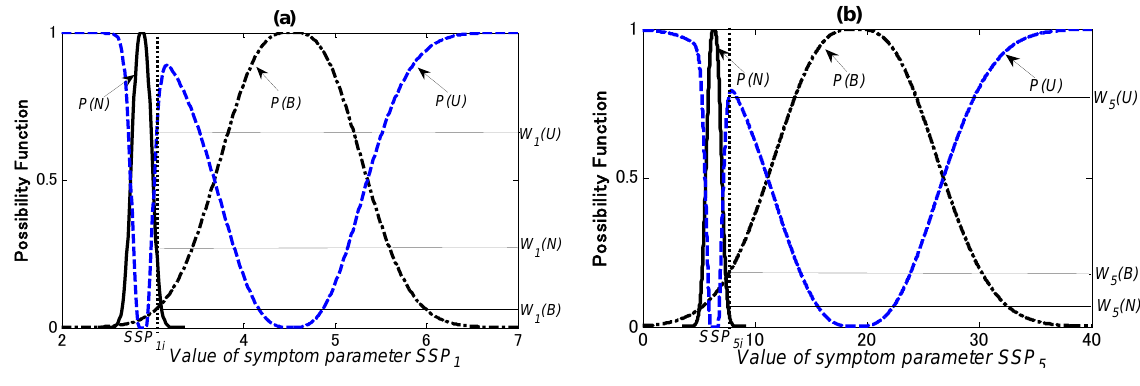
Figure 13. Possibility functions of ( a ) SSP